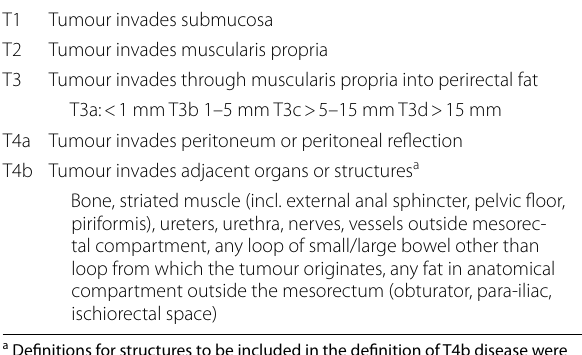
Table 1 Tumour (T) staging in rectal cancer